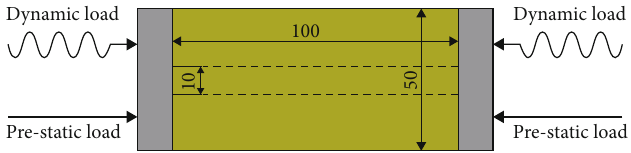
Figure 4: Schematic diagram of the combined dynamic and static loading of the test specimens. Table 1: Basic physical parameters and test plan of the rock